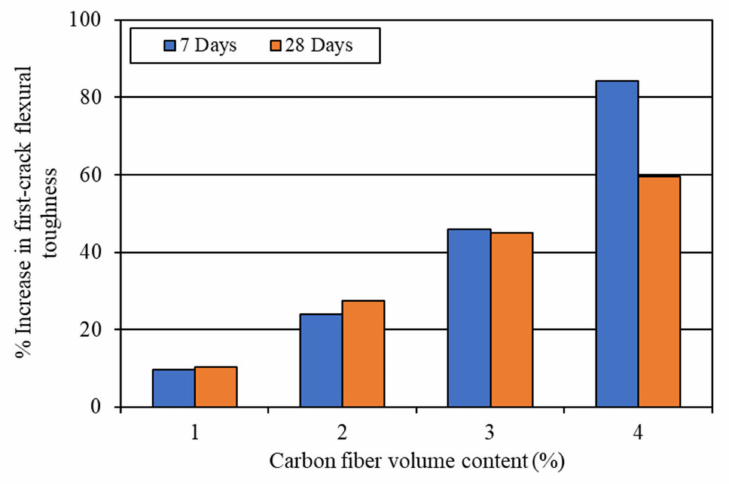
Figure 10. Increase in first-crack toughness due to the incorporation of carbon fibers.